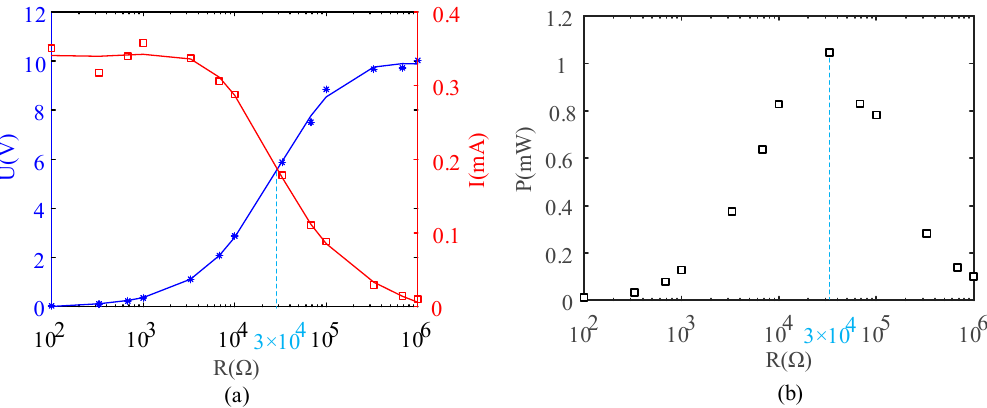
Figure 7. Influences of external resistance on ( a ) voltage and current peaks and ( b ) power.